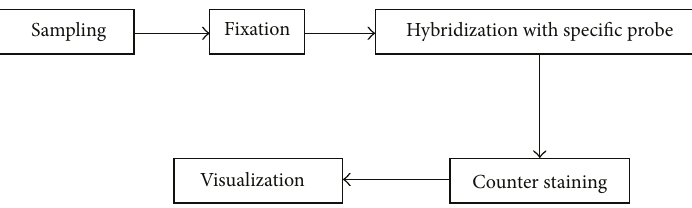
Figure 4: The in situ hybridization process can be divided into four stages: (A) sampling and immediate fixation in formaldehyde to preserve the integrity of the cells, especially the ribosomes; (B) hybridization with a specific probe, labelled with a fluorescent dye at its 50-end and matched with a sequence of the 16S rRNA; (C) counterstaining with a universal marker (DAPI, which attaches nonspecifically to DNA molecules) or another more general probe labelled with a different fluorescent dye; (D) visualization via fluorescence microscopy. Direct quantification is possible by manual counting of hybridized cells (epifluorescence and laser confocal microscope) or by image analysis of digital photos (both microscopes) or automated counting with a flow